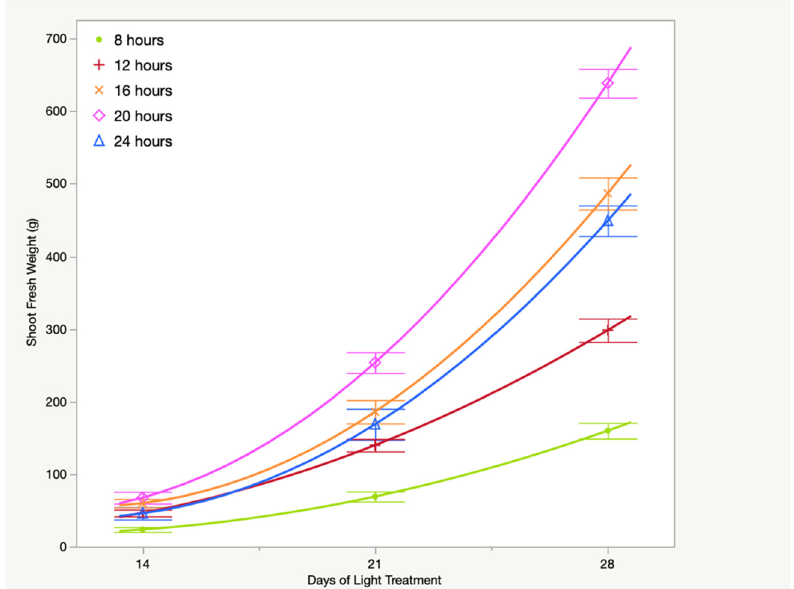
Figure 4. Mean shoot fresh weight (FW) of ice plant in response to photoperiod/daily light integral (DLI) treatment over time (plants harvested 14, 21, or 28 days after treatment). Data are means (± SE) of 3 experimental units times 3 replications over time. The green dot, red plus, orange x, pink diamond, and blue triangle represent 8/6.34, 12/9.50, 16/12.67, 20/15.84, and 24/19.01 h/mol·m − 2 ·d − 1 treatments, respectively.